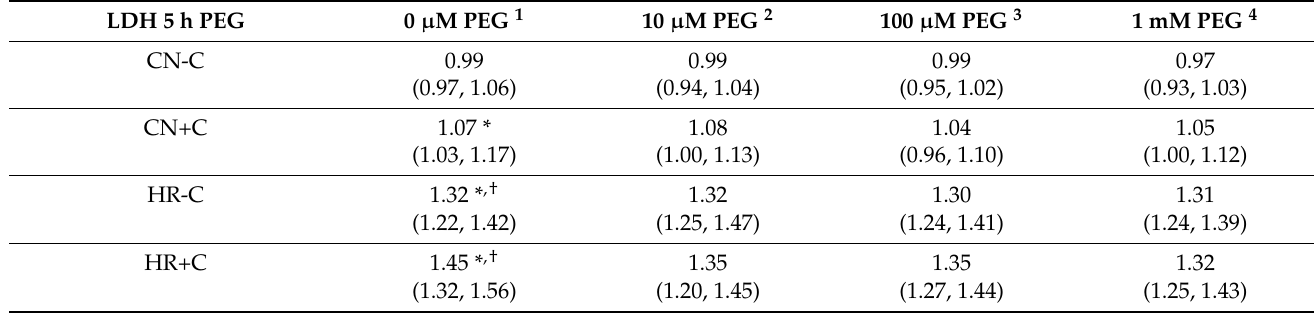
Table A9. Cytotoxicity/membrane damage after 5 h injury and treatment with 0 µ M, 10 µ M, 100 µ M, and 1 mM of PEG. Data from Figure A5 visualized as table (median, 25th, 75th percentile); p < 0.05; n = 6–7 experiments/group. Significances between different concentrations of PEG are displayed as superscripted numbers, significances between 0 µ M PEG CN-C, CN+C, HR-C, and HR+C are represented by symbols (* vs. CN-C 0 µ M PEG, † vs. CN+C 0 µ M PEG). Abbreviations: C, compression; CN, control/normoxia;